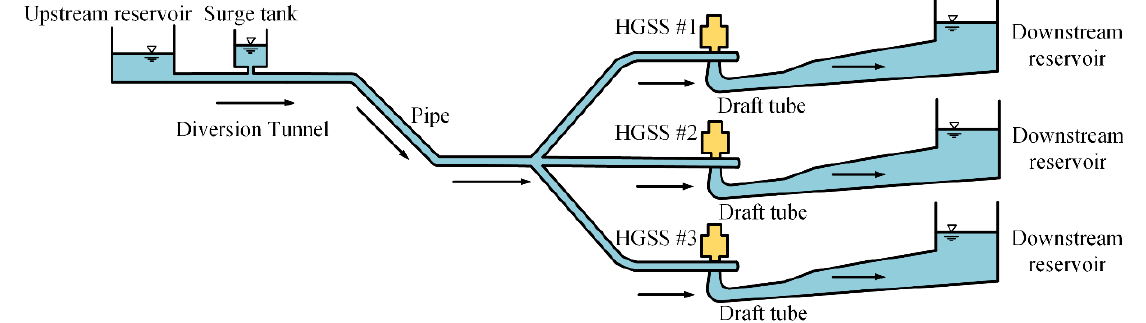
Figure 1. The schematic diagram of the HGS.